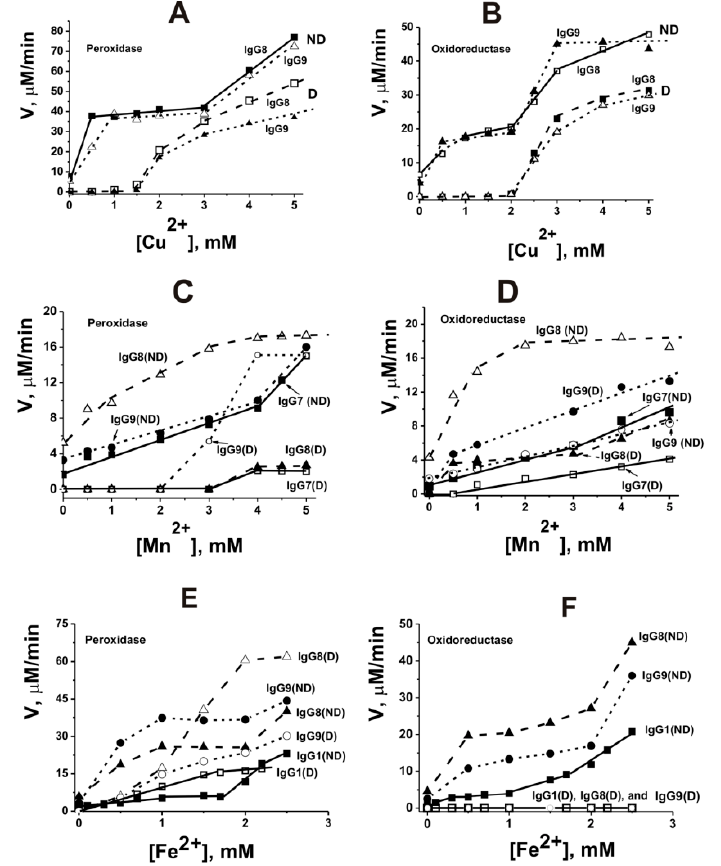
Figure 4. Dependencies of the peroxidase and oxidoreductase activities in the IgG-dependent oxidation of DAB (0.2 mg/mL) on the concentration of CuCl 2 ( A , B ), MnCl 2 ( C , D ), and FeCl 2 ( E , F ). Curves corresponding to dialyzed (D) and non-dialyzed (ND) IgGs (5 µg/mL) and numbers of IgG preparations are marked in Panels A – F [172].